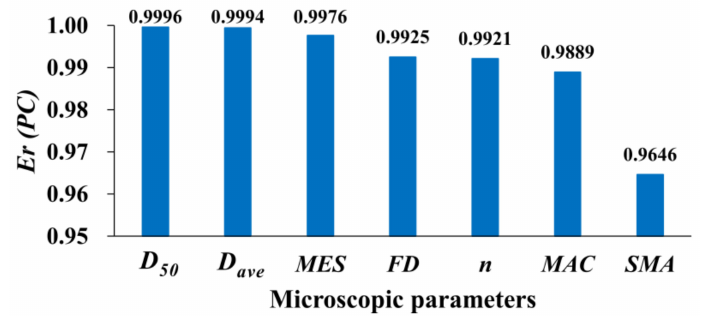
Figure 16. Grey relation entropy between PC and micropore